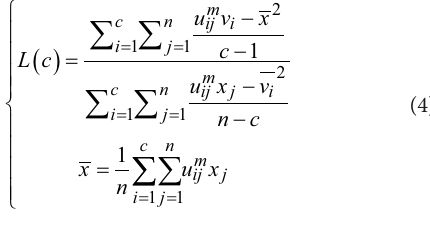
Figure 5 (Blue colors). In MZL, the SAM classification algorithm demonstrated positive and significant predictive validity for species richness ( R 2 = 0.62, RMSE = 1.44), Shannon-Wiener index ( R 2 = 0.64, RMSE = 0.16) and Simpson index ( R 2 = 0.44, RMSE = 0.05). In GGS,